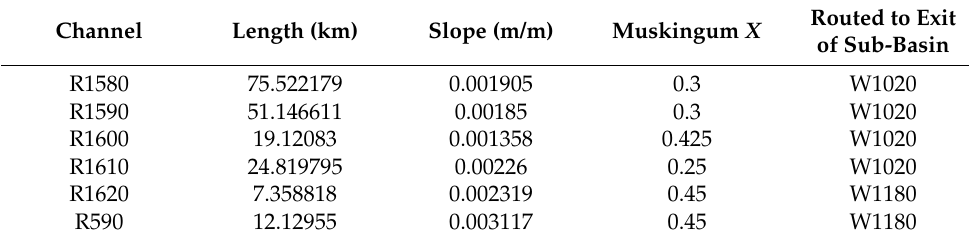
Routed to Exit of Sub-Basin